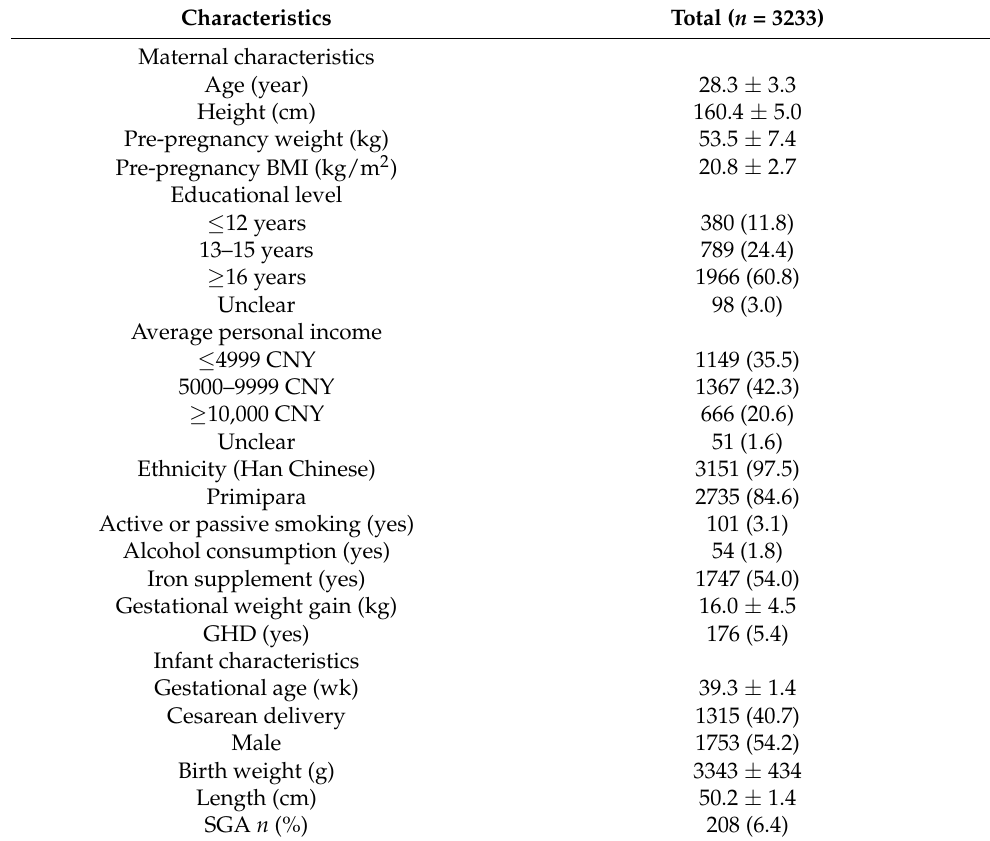
Table 1. Characteristics of the study population by SGA status †